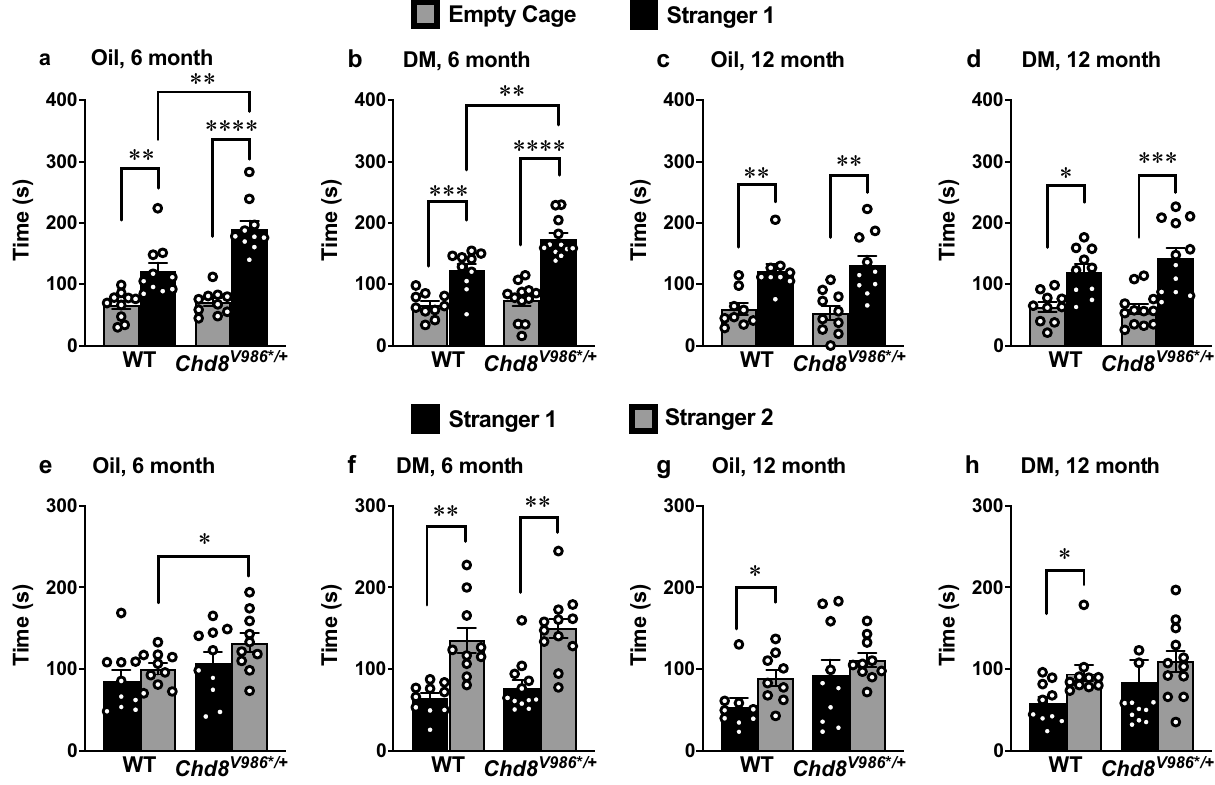
Figure 4. Social test in as a function of age and DM exposure in Chd8 V986*/ + mice. Mice were tested at 6 and 12 months of age. (a–d) Sociability assessed by the time spent in 5 cm proximity to a caged stranger or an empty cage. (e–h) Social novelty preference tested by the time spent in 5 cm proximity to each caged stranger mouse. Bars represent mean ± S.E.M. for a 10 min test. N = 10–12 mice per group. Fisher’s PLSD tests were used for comparing group means only when a significant F value was determined by using a two-way repeated measures ANOVA for each exposure and age group. *p < 0.05, **p < 0.01, ***p < 0.001, ****p <